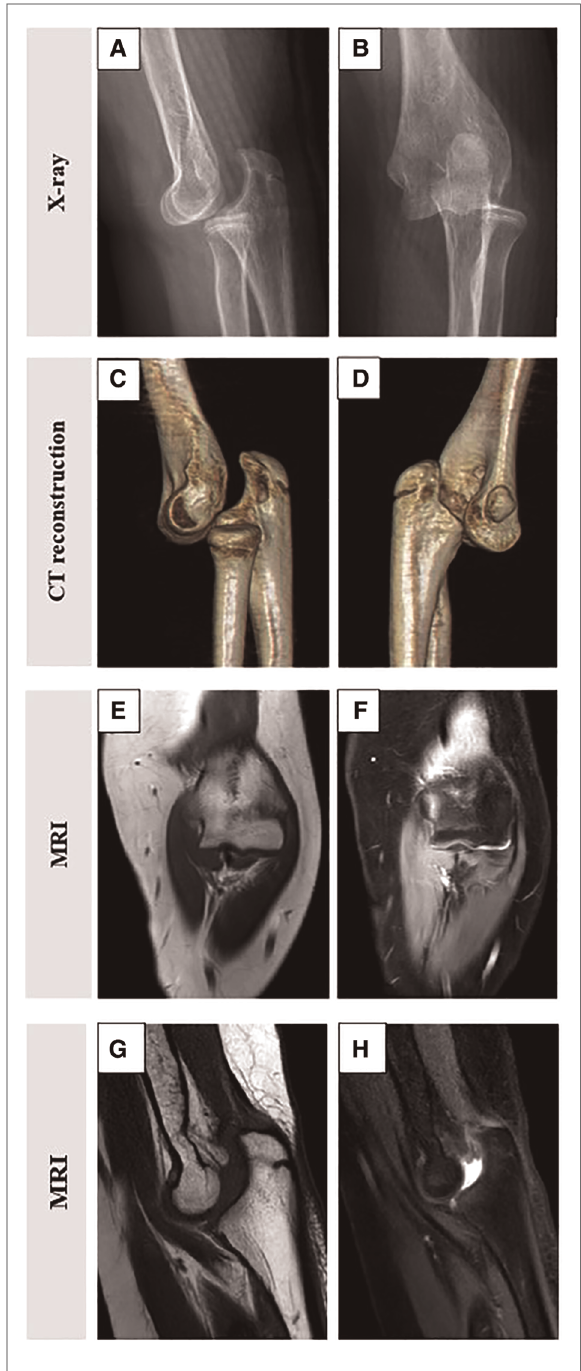
FIGURE 1 Preoperative imaging showing posterolateral dislocation of the left elbow. ( A,B ) Radiographs show anteriorly inferior slippage of the distal humerus without fracture; ( C,D ) Three-dimensional computed tomography shows a transverse defect of the coronoid process of the ulna, ( E,F ) The MRI of left elbow shows no injury of medial collateral ligament and lateral collateral ligament. ( G,H ) The MRI of left elbow shows posterolateral